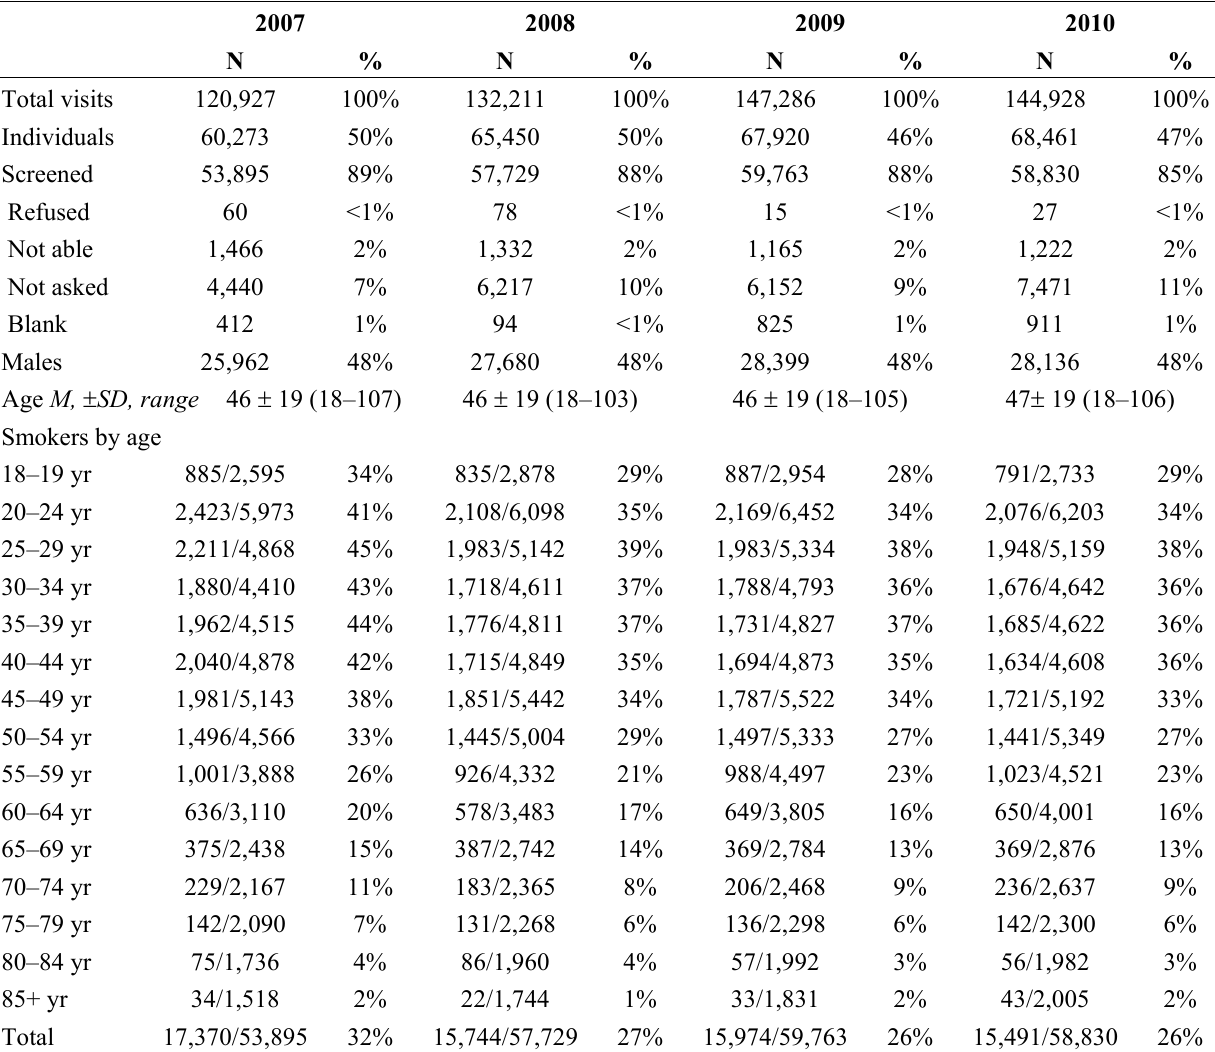
Table 1. Tobacco Use Screening and Prevalence by